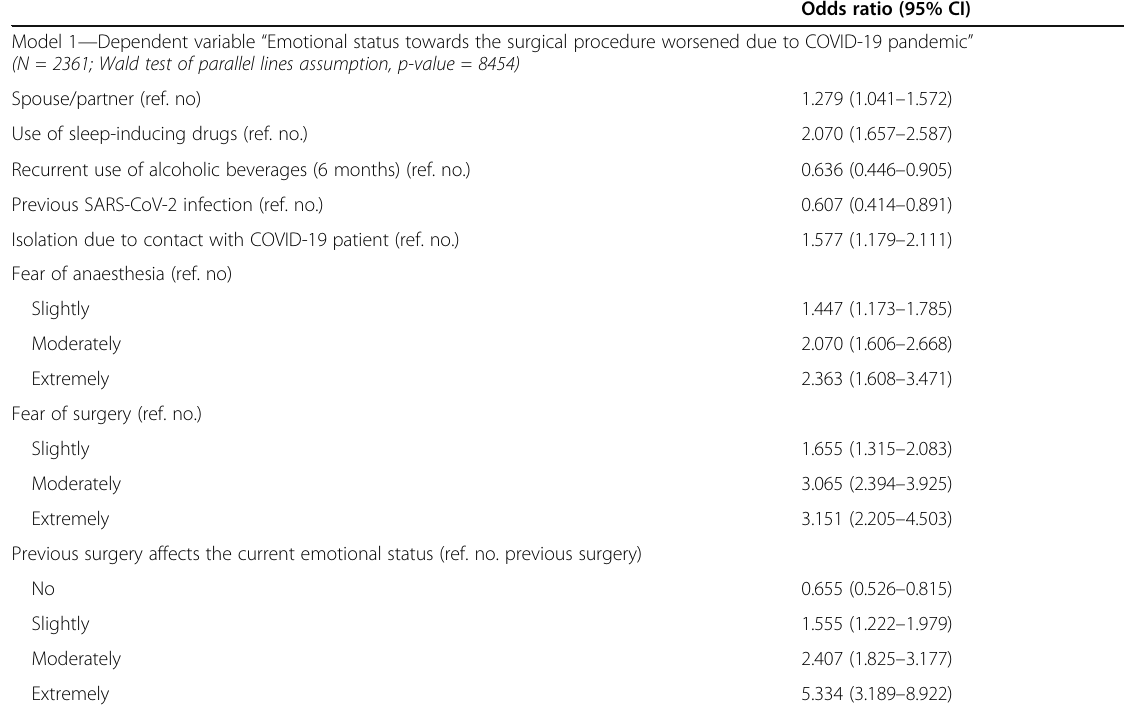
Table 2 Multivariable ordered logit